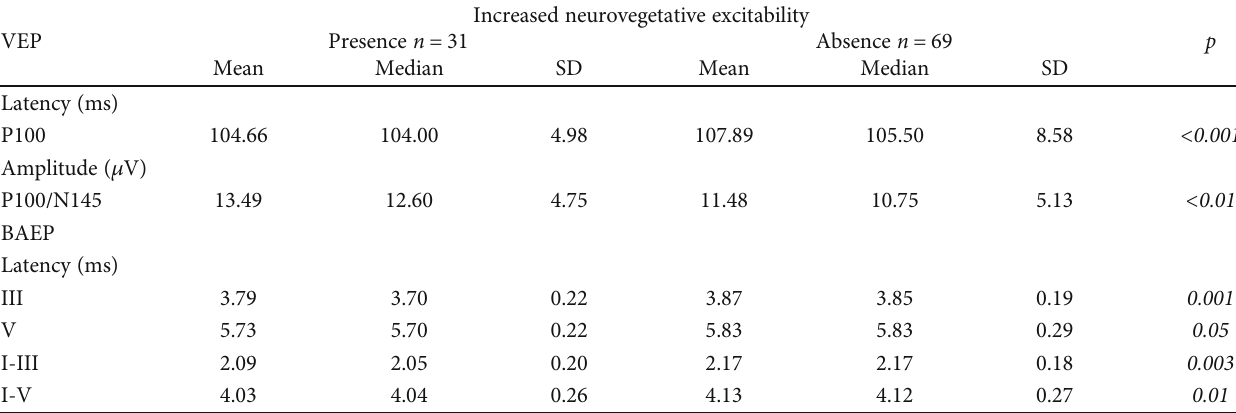
Table 7: Signi fi cant changes in VEP and BAEP parameters depending on increased neurovegetative excitability in patients with HT.